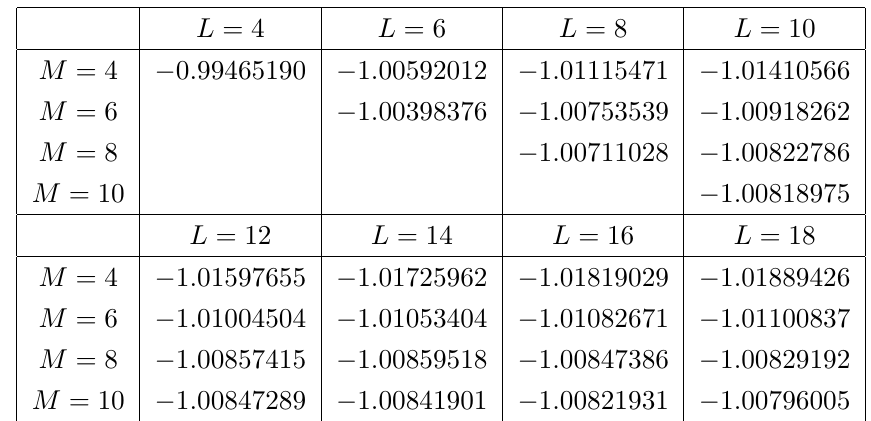
Table 5 . Predicted values of the energy E M ( L ) obtained from the interpolating potentials V M in Schnabl gauge, at various orders of M and for L (cid:20) 18. In the top half of the table, the value